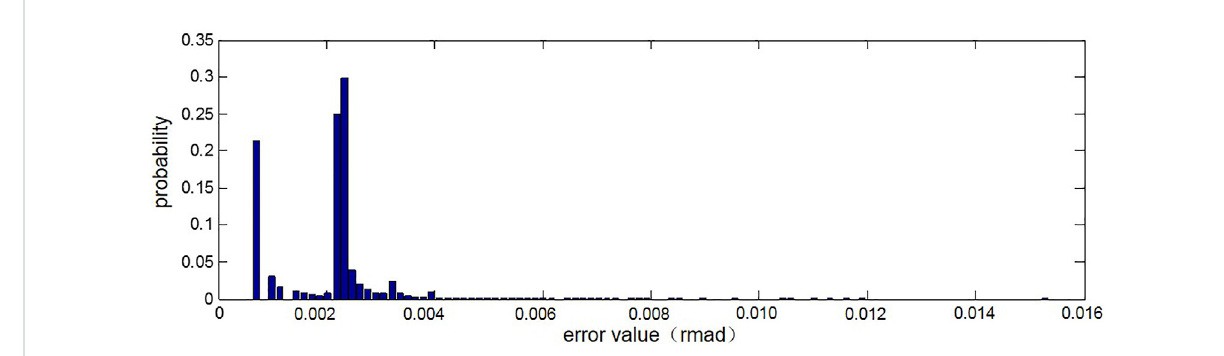
FIGURE 7 Statistical histogram of error in the fi rst image phase unwrapping.